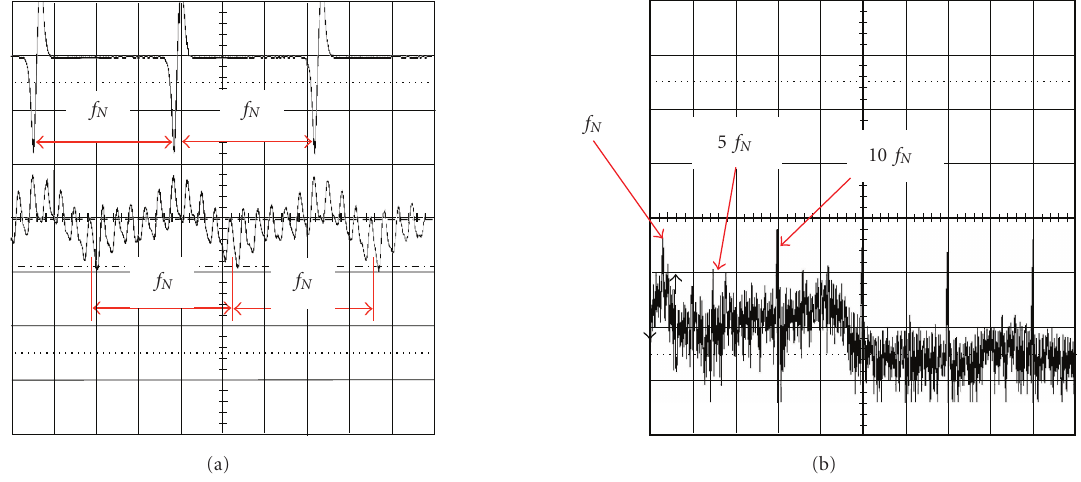
Figure 17: (a) Pressure fluctuations over three-time periods; (b) associated power spectrum—sensor Cp3 of splittered pump at BEP.